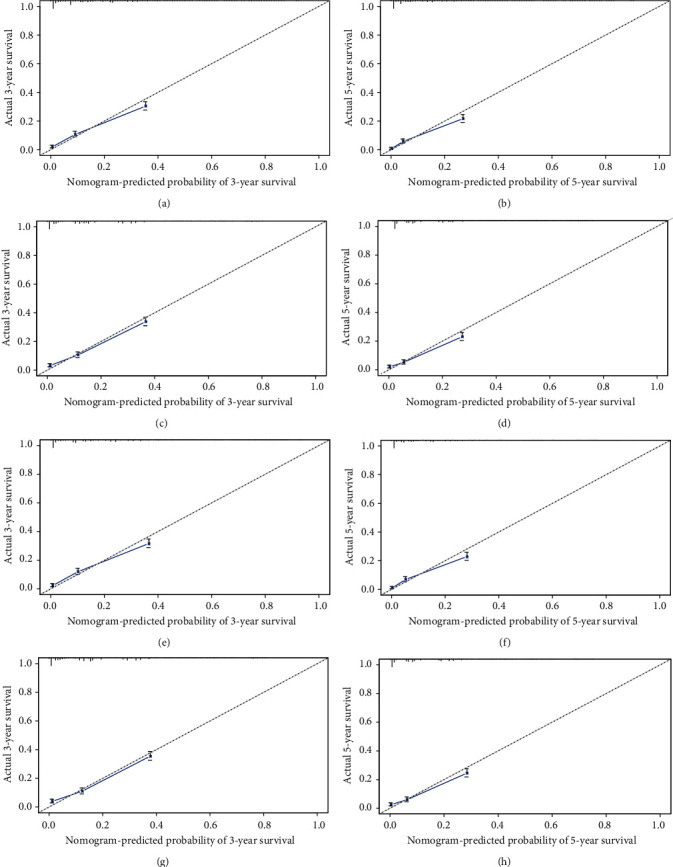
Discriminatory accuracy for predicting OS assessed by receiver operator characteristics (ROC) analysis calculating area under the curve (AUC). The 3- and 5-year OS in the training set (a, b) and 3- and 5-year OS in the validation set (c, d). The 3- and 5-year CSS in the training set (e, f) and 3- and 5-year CSS in the validation set (g, h).